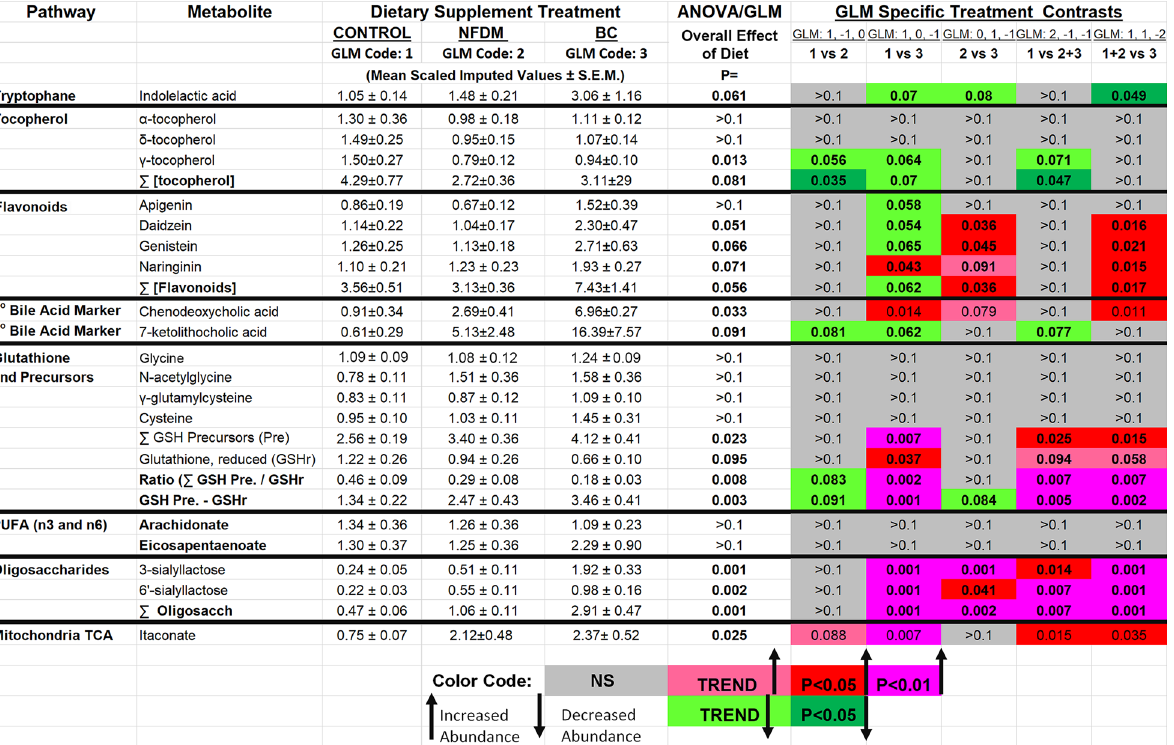
Table 1 The effects of inclusion of nonfat dry milk (NFDM) or the bovine colostrum fraction (BC) on ileal digesta components with literature-supported anti-inflammatory effects on tissues varied according to the involved biochemical pathway components